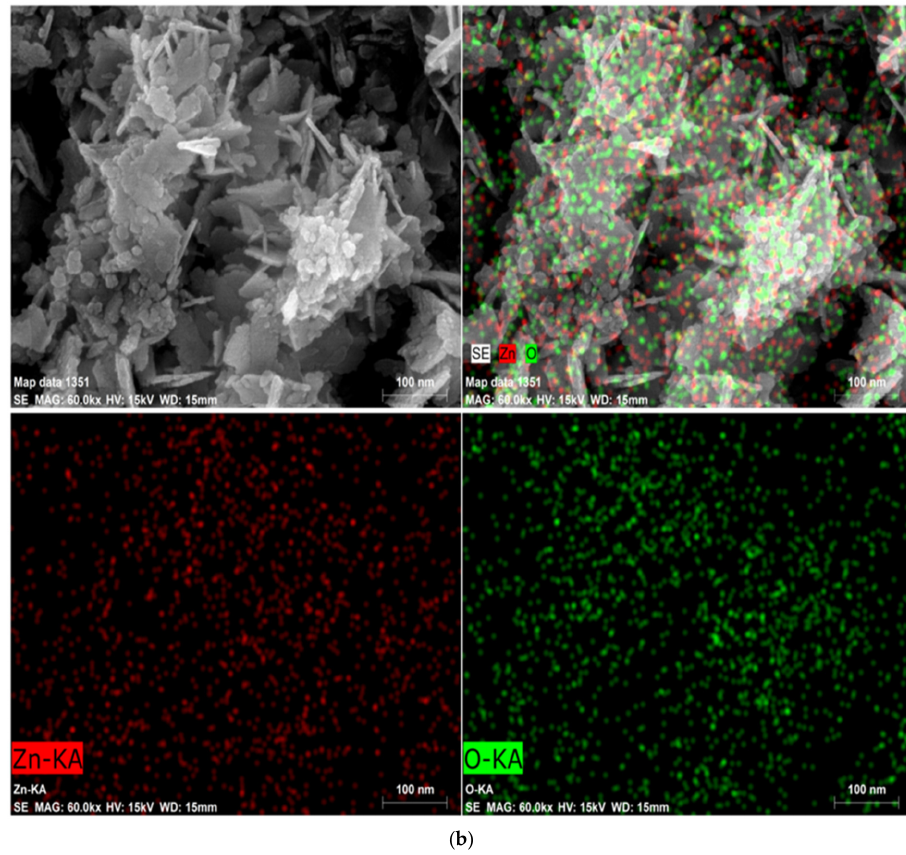
Figure 5. FE-SEM micrographs ( a ) and Elemental mapping ( b ) of ZnO-NPs. Reference 1. Dhatwalia, J.; Kumari, A.; Chauhan, A.; Mansi, K.; Thakur, S.; Saini, R.V.; Guleria, I.; Lal, S.; Kumar, A.; Batoo, K.M.; et